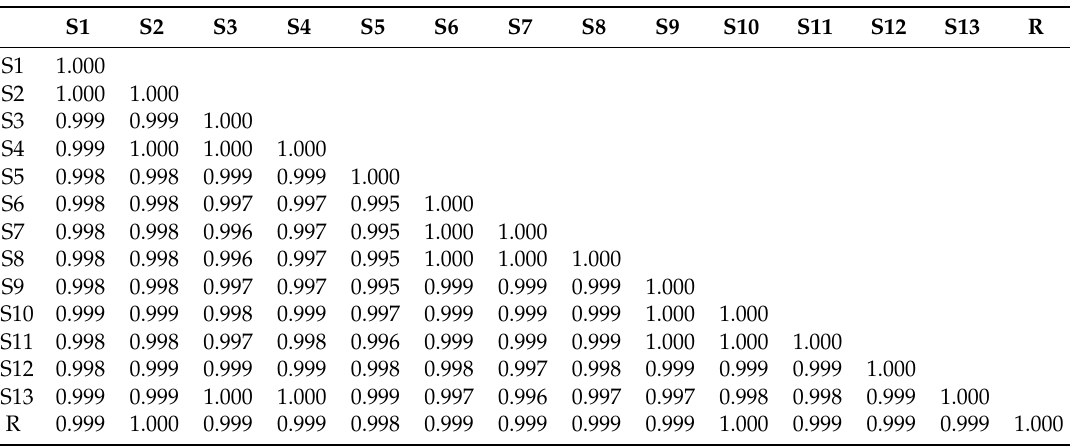
Table 4. Similarities among amino acids from 13